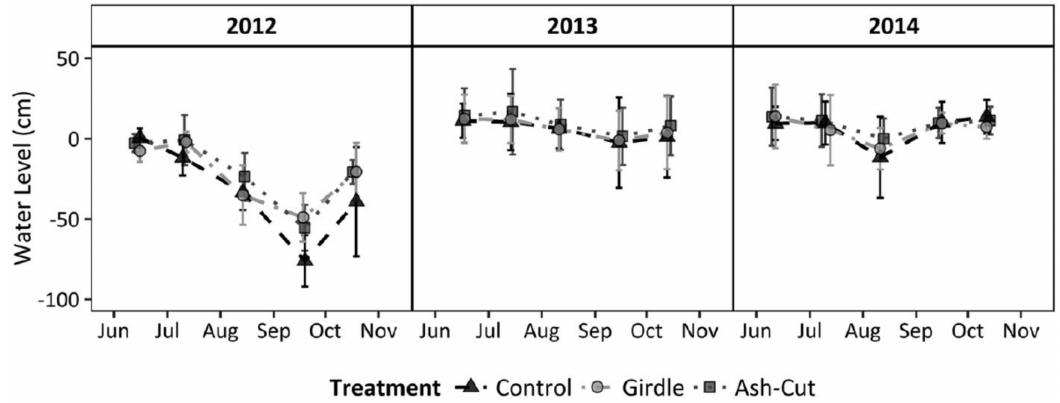
Figure 3. Mean wetland water table levels relative to the wetland soil surface, with 95% confidence intervals, during the snow-free period for the upper Michigan sites ( n = 3). The year 2012 was the pre-treatment year and 2013–2014 were the first two post-treatment years (reprinted from Van Grinsven et al. [7]). The control treatment comprised unharvested reference sites, all ash trees were girdled in the girdle treatment, and all ash were cut and left on the ground in the ash-cut